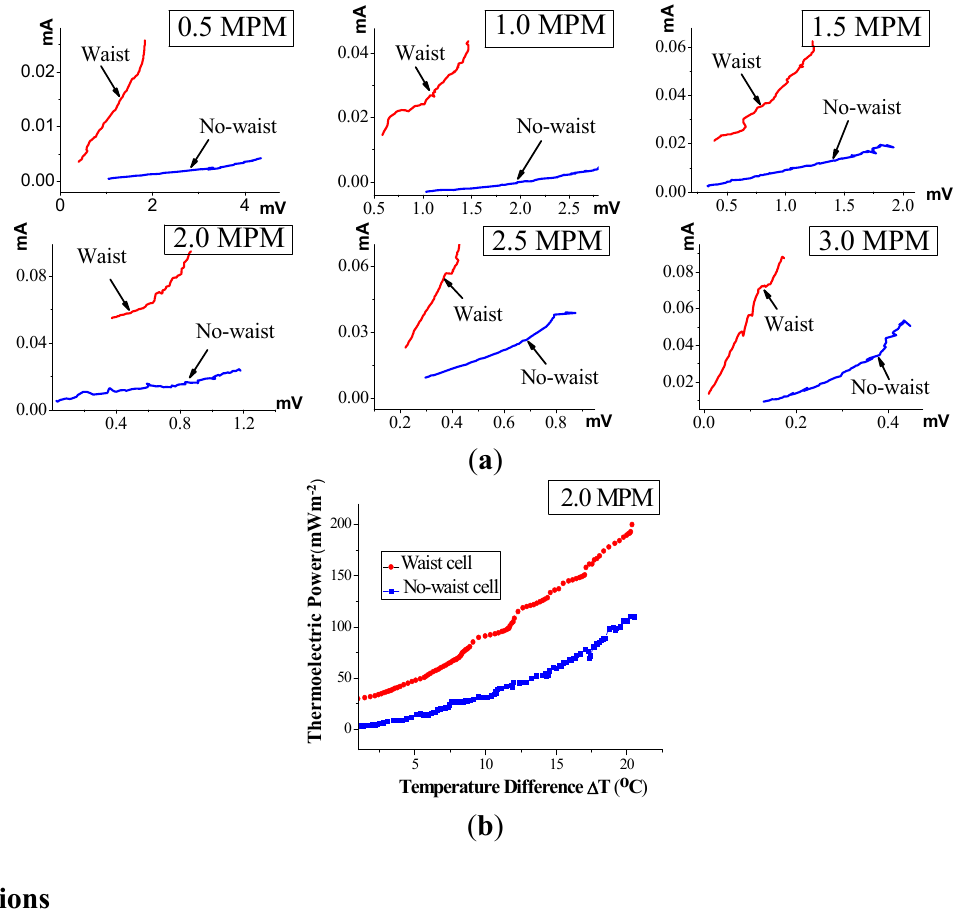
Figure 7. Thermoelectric comparison of the waisted and no-waisted cells over the Δ T interval of 0–20 °C (the time interval from 2400 s to 3200 s): ( a ) real-time current vs. voltage characteristics; and ( b ) 2.0 MPM thermoelectric power